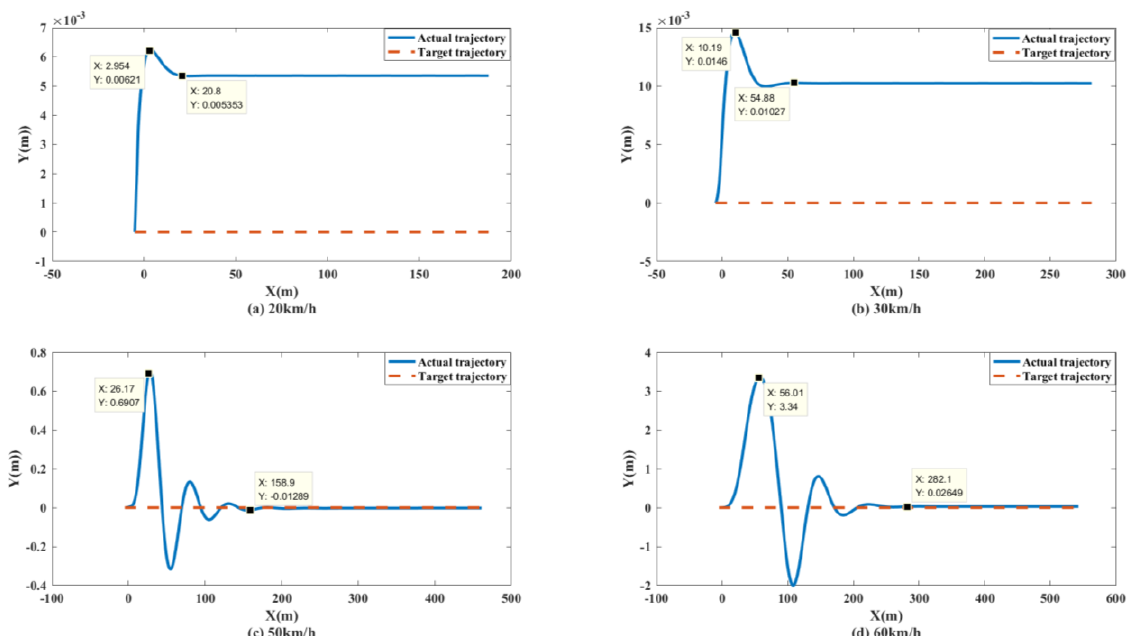
Figure 14. Path tracking curves of unmanned vehicles at different speeds on the split mu straight road.